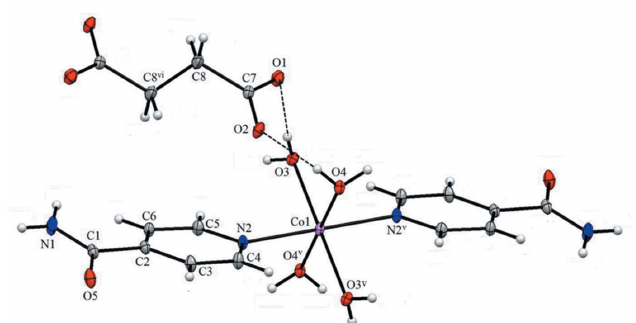
Figure 1 The molecular structure of the title complex, with the atom labelling.